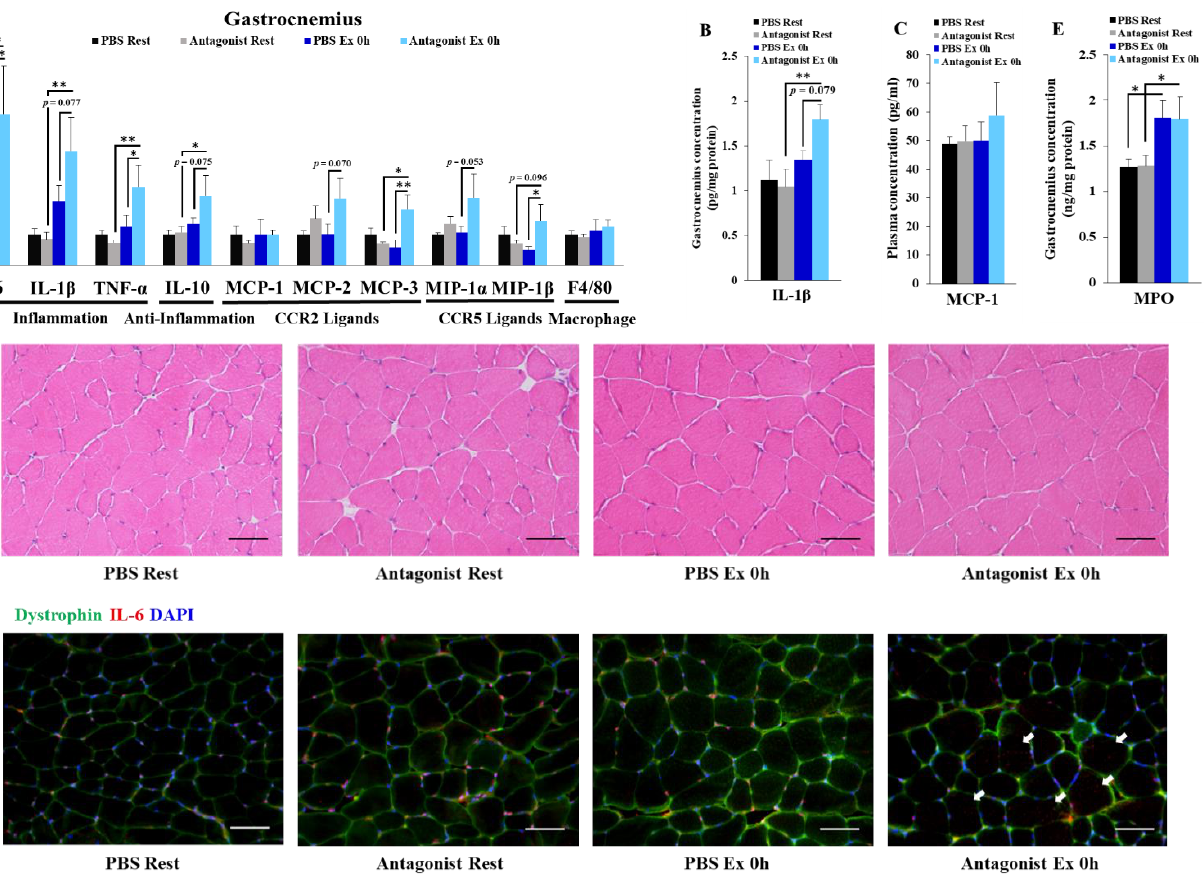
Figure 2. ( A ) Gene expression of inflammation ( n = 5 – 6). ( B ) Gastrocnemius IL- 1β concentration s ( n = 6). ( C ) Representative images of gastrocnemius sections using immunofluorescence staining (green, dystrophin; red, IL-6; blue, DAPI; magnification ×200, n = 2). Arrowheads indicate IL-6 positive muscle fibers. Scale bar is 50 µm. ( D ) Representative images of gastrocnemius sections using H&E staining (magnification ×200, n = 2). Scale bar is 50 µm. ( E ) Plasma MCP-1 concentrations ( n = 5 – 6). ( F ) Gastrocnemius MPO concentrations ( n = 6). Data are shown as mean ± SE. Data were analyzed using two-way ANOVA followed by Bonferroni post hoc test (* p < 0.05, ** p < 0.01). IL, interleukin; TNF- α, tumor necrosis factor - α; MCP, monocyte chemoattractant protein; MIP, macrophage inflammatory protein; MPO, myeloperoxidase; ANOVA, analysis of variance; SE, standard error.